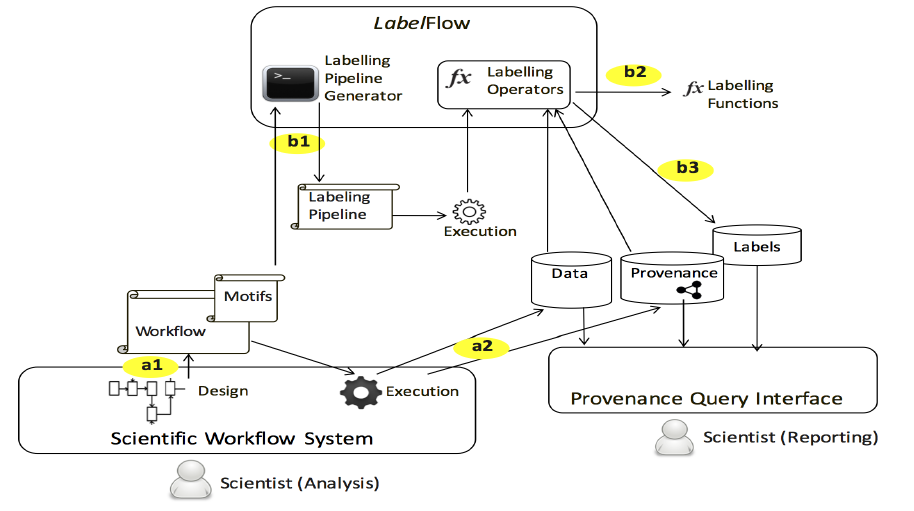
Figure 7. Label Flow